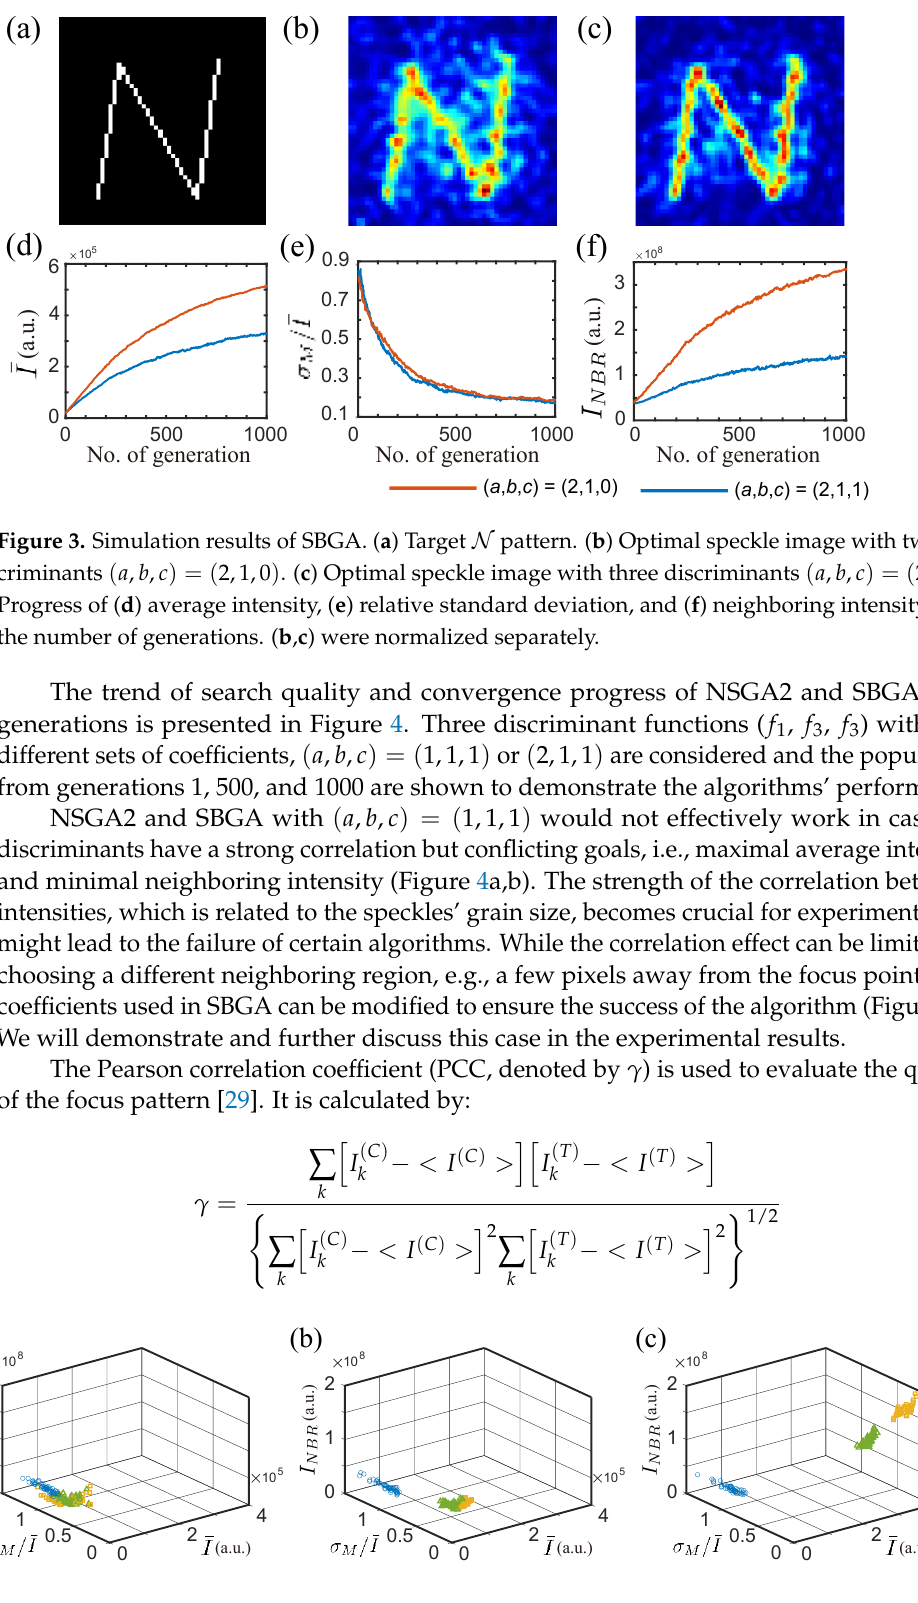
Figure 4. Simulation results considering 3 discriminants for ( a ) NSGA2, ( b ) SBGA with ( a , b , c ) = ( 1,1,1 ) , and ( c ) SBGA with ( a , b , c ) = ( 2,1,1 ) . The solutions from generations 1 (ran- dom phase masks), 500, and 1000 (last generation) are